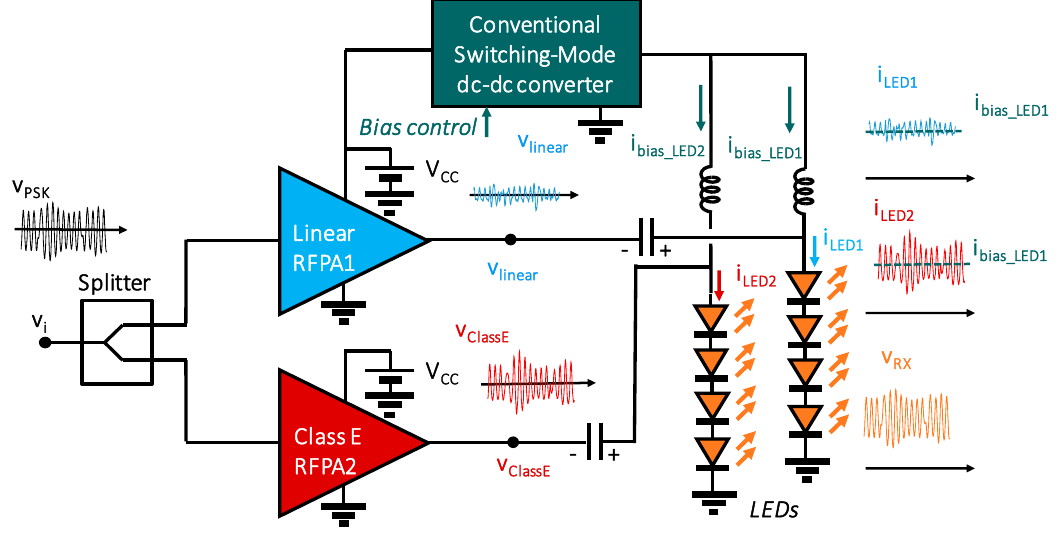
Figure 10. Adapting the Linear-Assisted technique to a Class E RFPA as a VLC-LED driver, exploiting summing the light. This scheme is only valid for PSK modulation schemes.